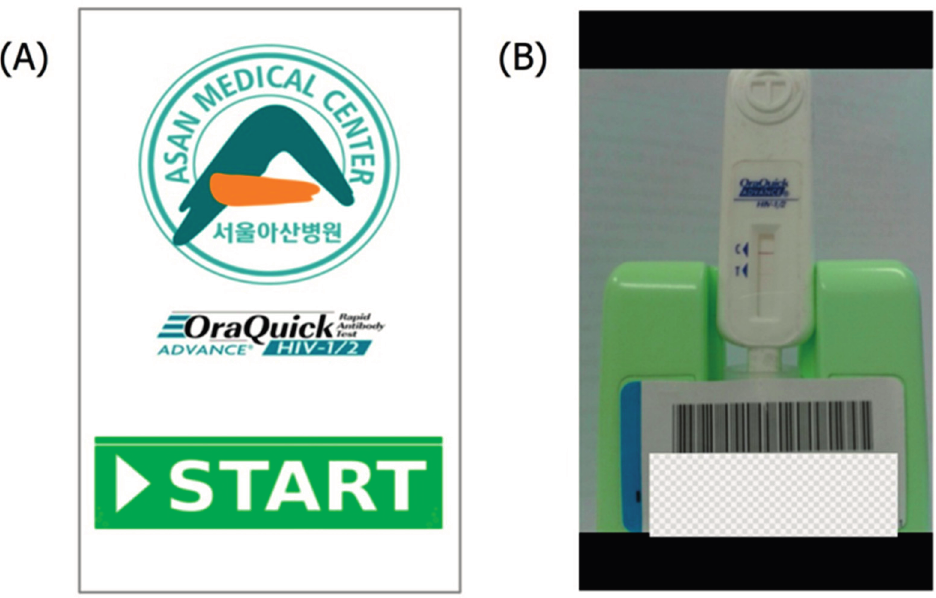
Figure 2. “Point-of-care HIV Check” application. ( A ) Screenshot of main menu; ( B ) Screenshot of barcode reading